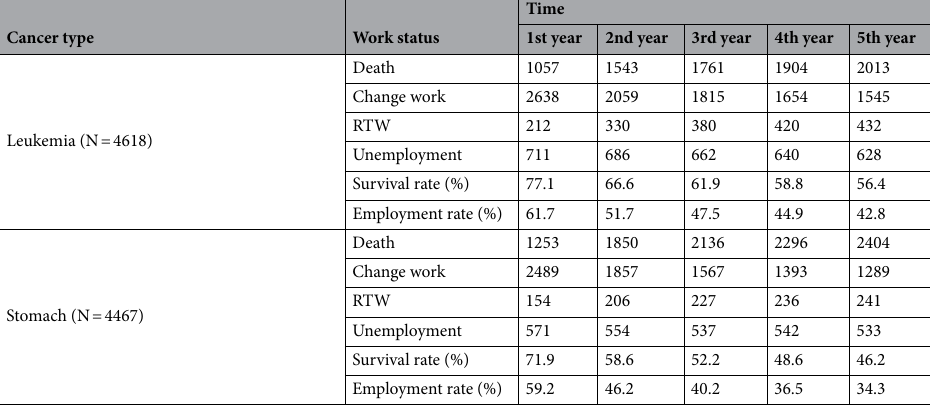
Table 2. Longitudinal distribution of workers with cancer in 5 years (2004–2010).